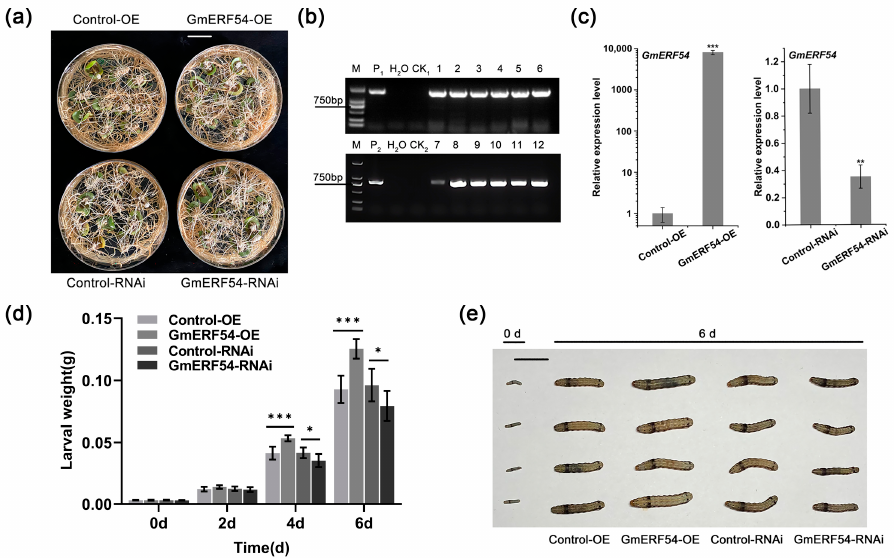
Figure 4. GmERF54 transgenic soybean hairy roots and evaluation of CCW resistance. ( a ) GmERF54 transgenic hairy roots. Scale bar = 2 cm. ( b ) Identification of transgenic soybean hairy roots at the DNA level. M: DNA Marker DL 2000; P 1 : pMDC83-GmERF54 plasmid; P 2 : pB7GWIWG2(II)-